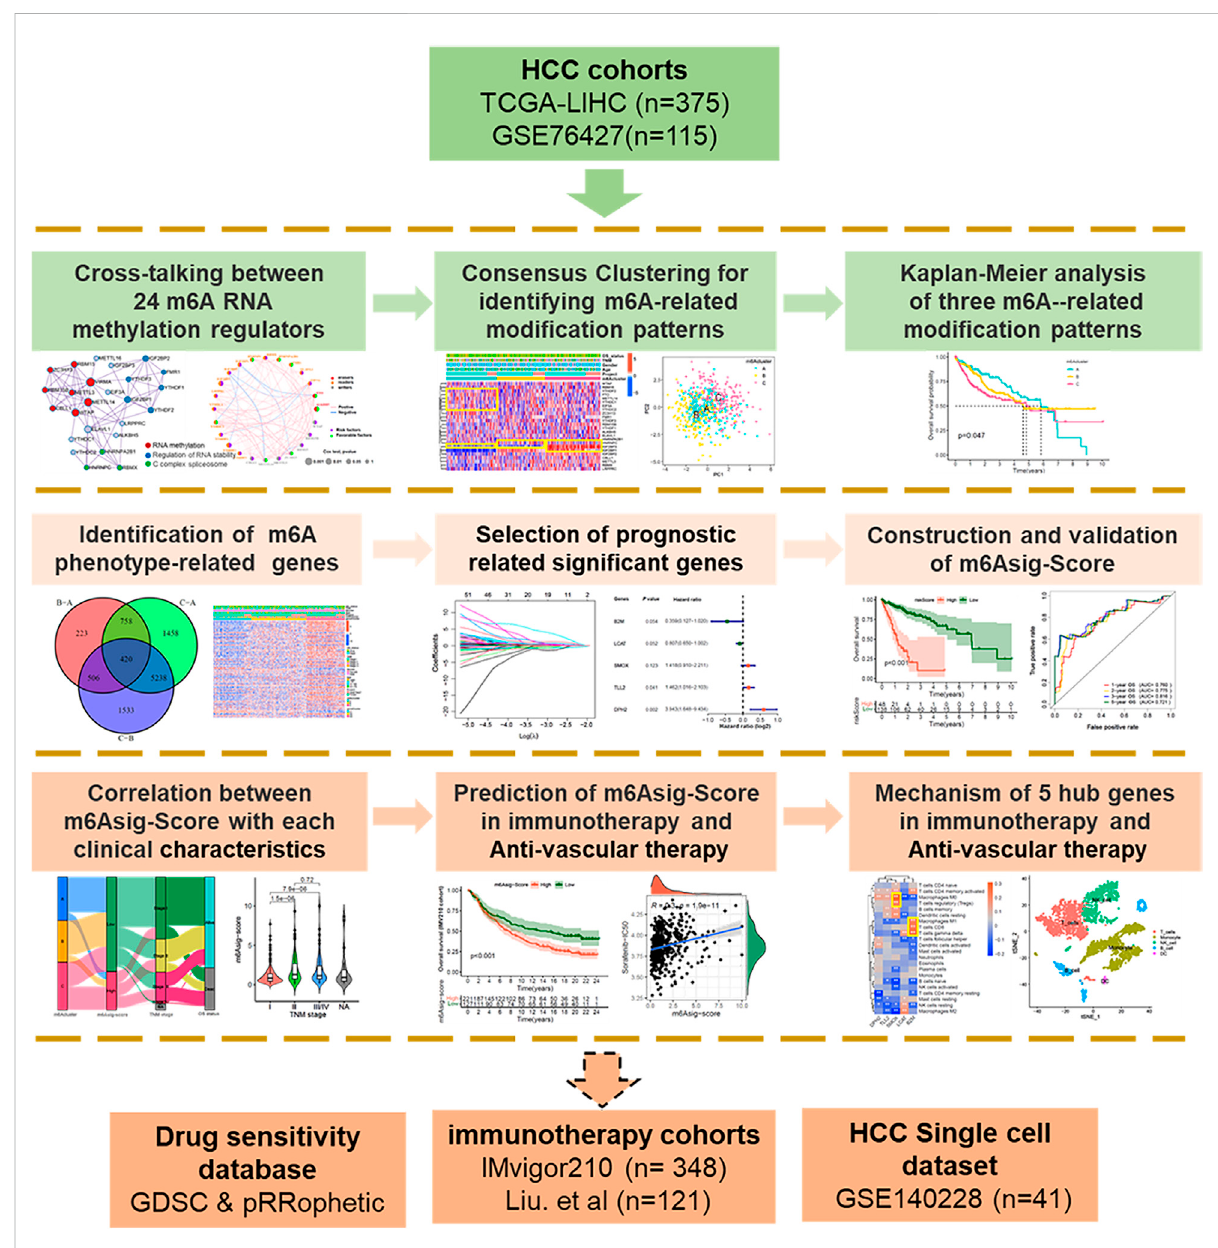
FIGURE 1 Overviewofstudydesign.Atotalof490HCCsampleswithcompletedtranscriptomeandsurvivalinformationwereconcludedinthisstudy.We fi rst explored the multi-omics characteristic landscapes of 26 m6A regulators and identi fi ed three different m6Aclusters with distinct immune and angiogenesisphenotypes. Then,wefurtherconstructeda5-genesprognosissignaturetermedas “ m6Asig-Score ” basedon420m6A-relatedDEGs. Thepatientswithhighm6Asig-Scorewereassociatedwithpoorprognosis,advancedTNMstageandhighTP53mutationfrequency.Finally,we explored the capability of m6Asig-Score and 5 hub genes in predicting immunotherapy and anti-angiogenic ef fi cacy. Two independent immunotherapy cohorts (IMvigor210 and Liu. et al. cohorts) and the Genomics of Drug Sensitivity in Cancer (GDSC) database were used to validate the immunotherapy and anti-angiogenic ef fi cacy respectively. And the HCC single immune cells sequencing datasets GSE140228 were performed to present the expression distribution of 5 hub